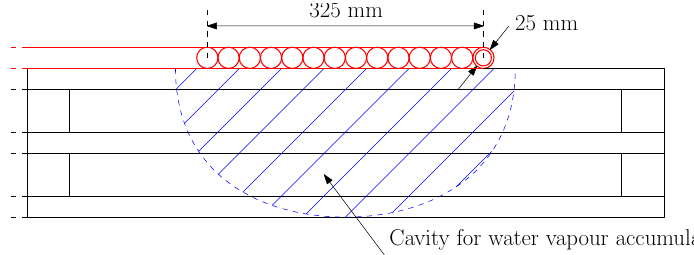
Figure 3. Section A—Detail. Underneath the heat exchanger, the cavity is formed for water vapour